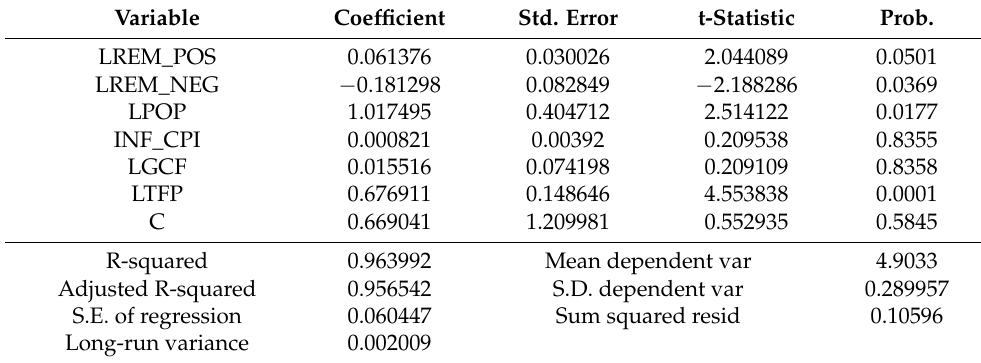
Table 8. Method: Fully Modified Least Squares